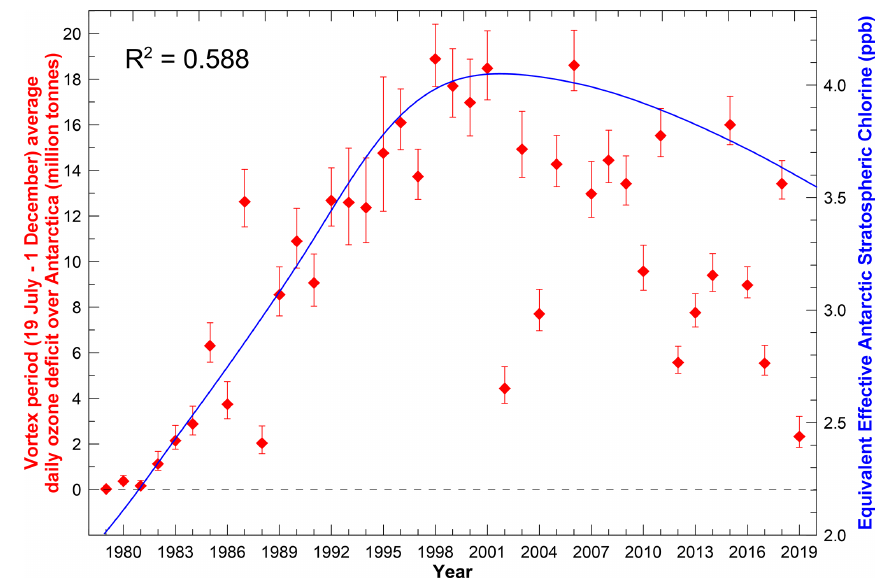
Figure 1. Antarctic vortex period (AVP; day 200 to 335) average daily ozone mass deficit plotted against the left y axis (red) and equivalent effective Antarctic stratospheric chlorine (EEASC) plotted against the right y axis (blue). The R 2 value shows the correlation coefficient between the two time series over the full